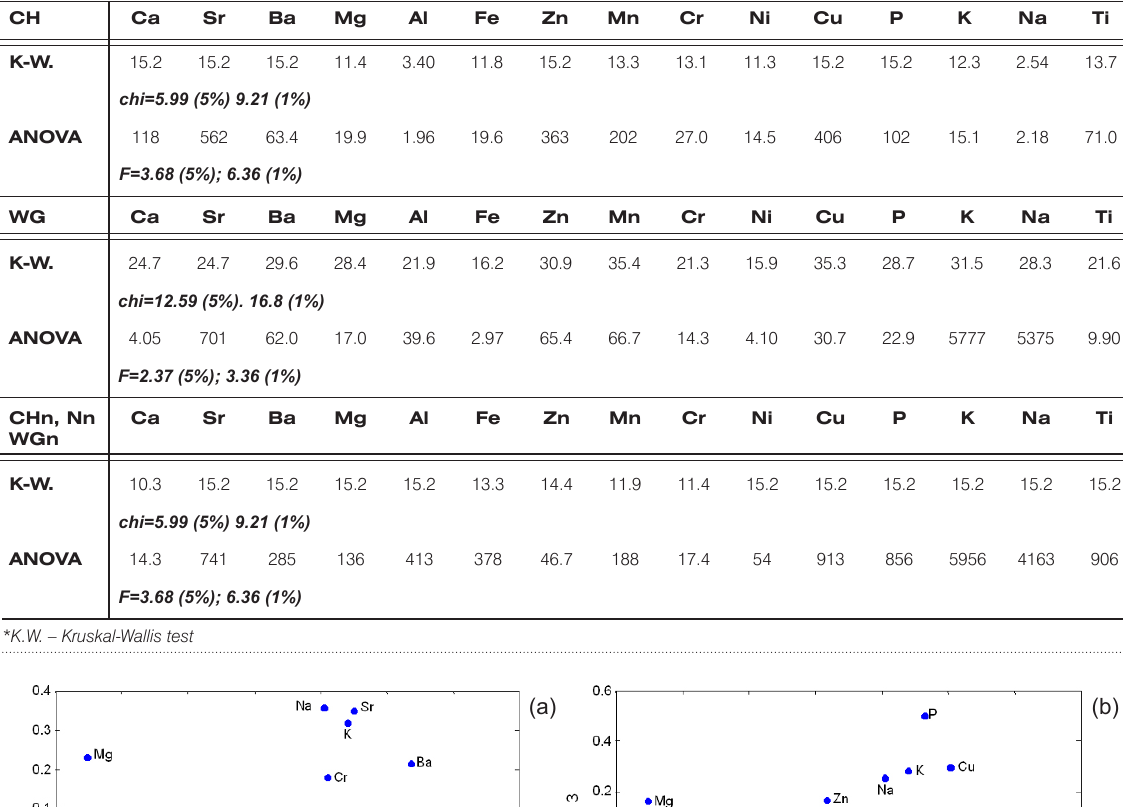
Table 6. The results of one-way ANOVA and Kruskal-Wallis one-way analysis of variance for three types of activated carbons. CH Ca Sr K-W.